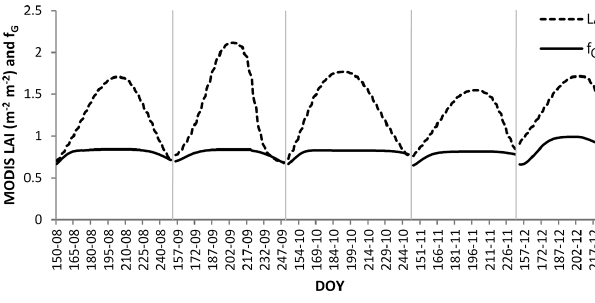
Figure 6. Mean MODIS LAI and fraction of green vegetation ( f g ) temporal dynamics for all flux stations from 2008 to 2012.